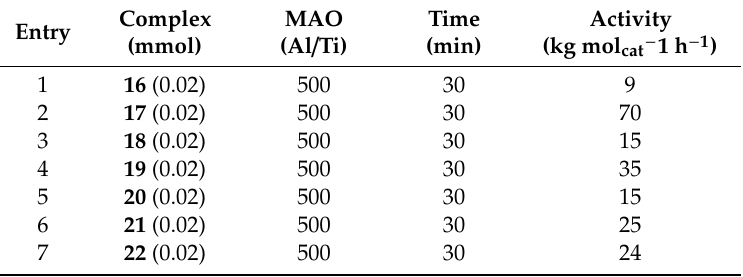
Figure 6. Titanium-calix[4]arene complexes disclosed by Ladipo et al. [12]. Table 6. Polymerization of ethylene catalyzed by 16–22 /MAO systems [12].